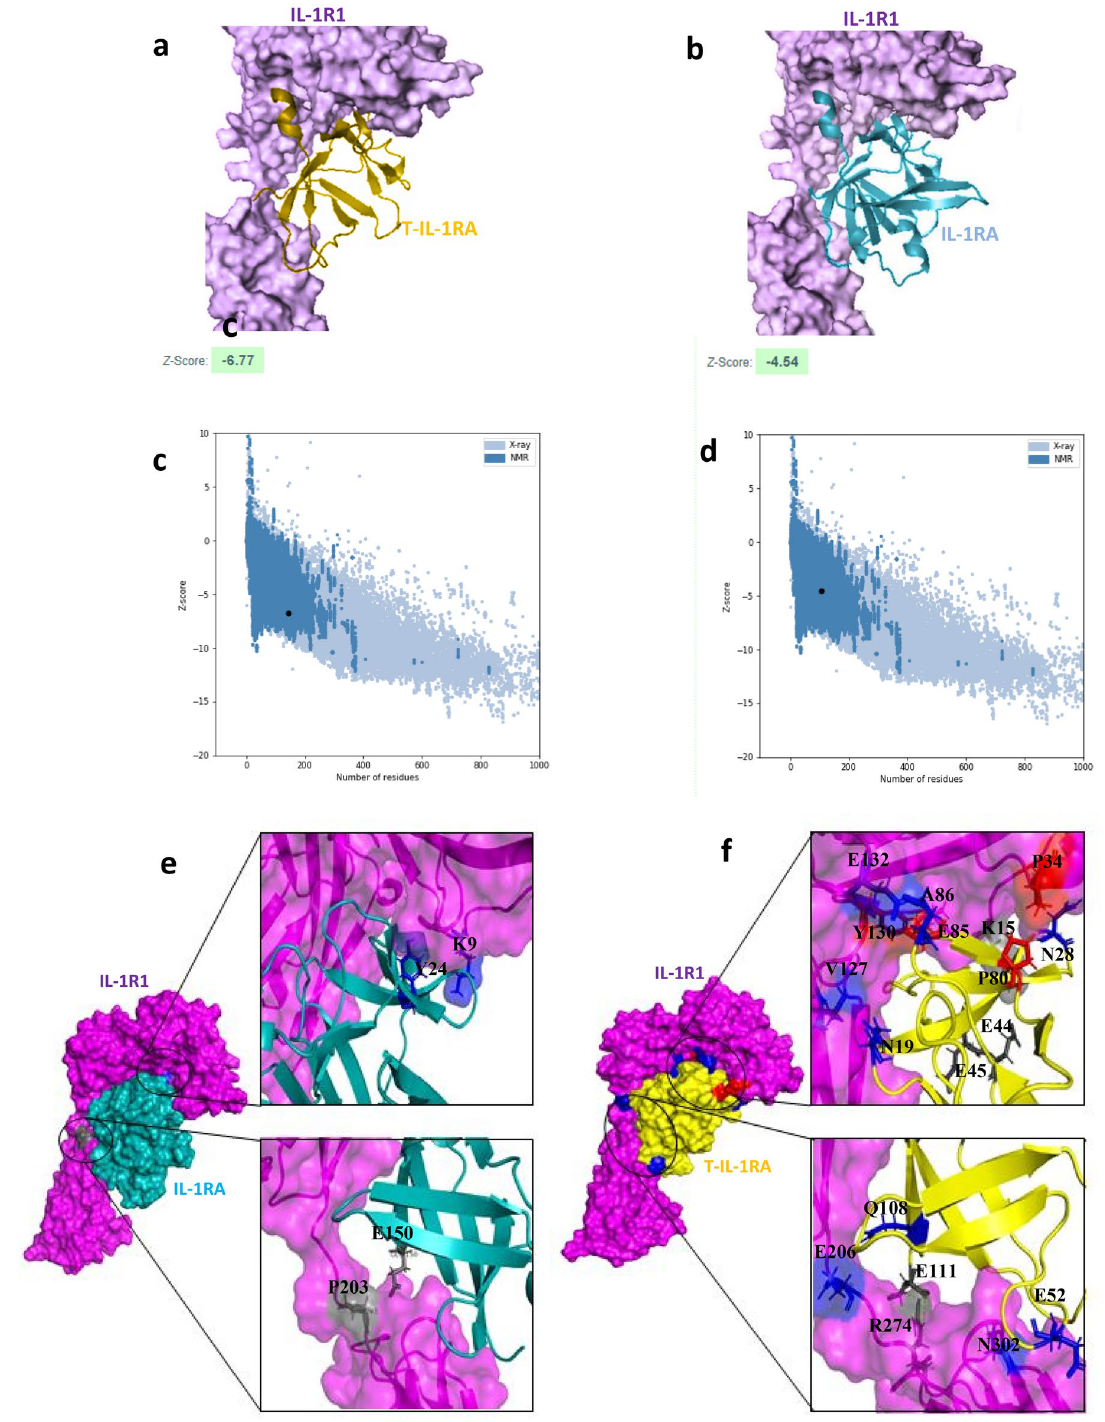
Figure 3. 3D structure comparison of IL-1RA and T-IL-1RA in complex with their receptor IL-1R1. ( a ) 3D structure of IL-1RA in complex with IL-1R1. ( b ) 3D structure of T-IL-1RA in complex with IL-1R1. ( c ) Structure model validation of native and ( d ) Truncated ligands, using ZDOCK server. ( e ) Residues of native ligand involved in interaction with IL-1R1 which do not make contact with receptor in truncated ligand/ receptor complex. ( f ) New residues of Truncated ligand involved in interaction with IL-1R1 which do not make contact with receptor in Native ligand/receptor complex. Specific interactions of IL-1RA/IL-1R1 Hydrophobic interaction (red), Hydrogen bond (blue), and Ionic interaction